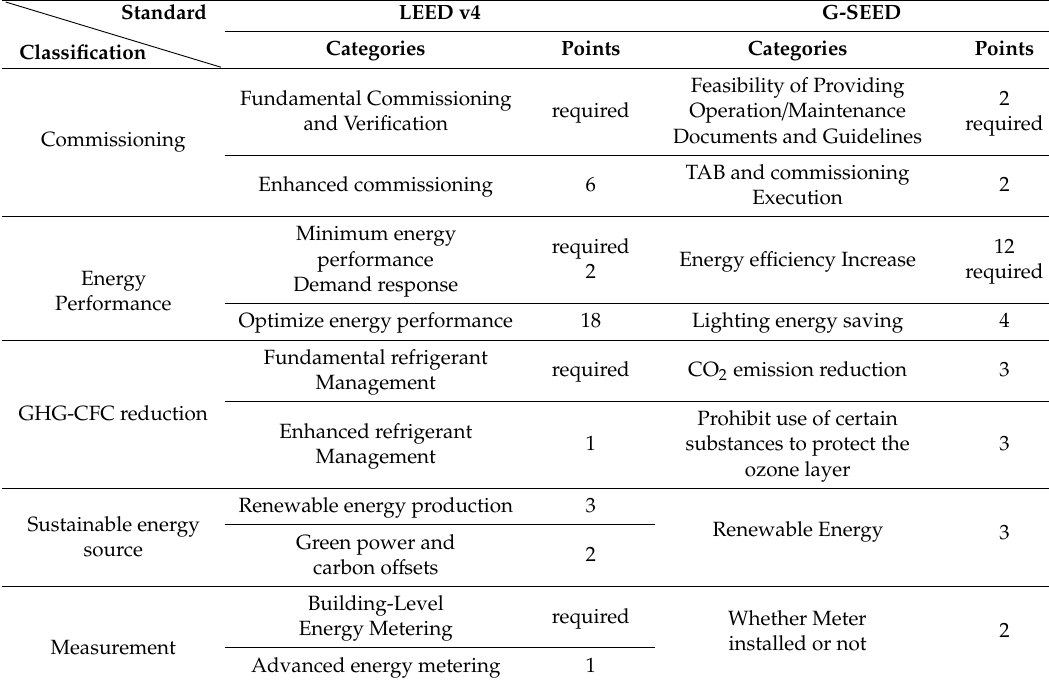
Table 4. Comparison of LEED and G-SEED energy evaluation categories. ClassificationStandard LEED v4 G-SEED Categories Points Categories Points Feasibility of Providing required Operation / Maintenance Documents and